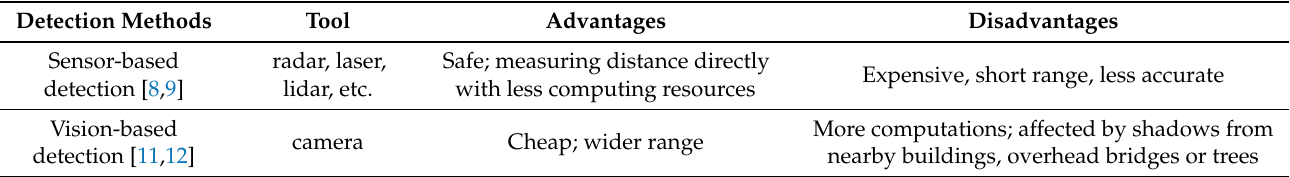
Table 2. Comparison of collison detection ways.